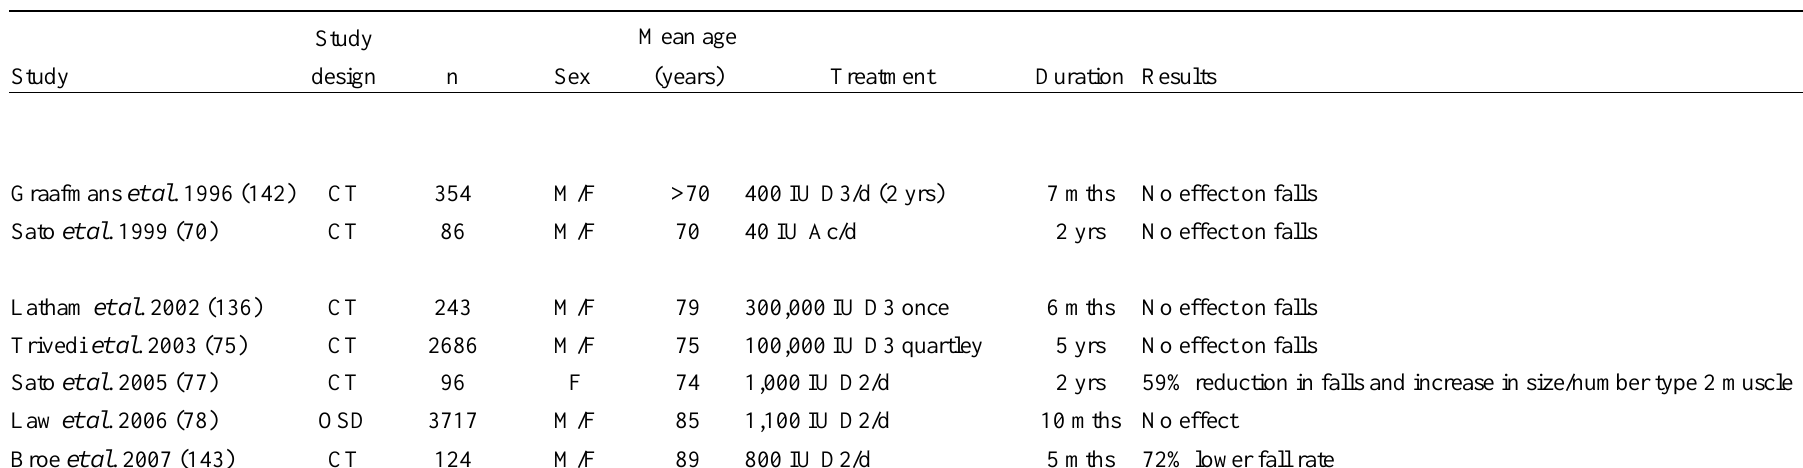
Table 6. Intervention with vitamin D or vitamin D analogues on